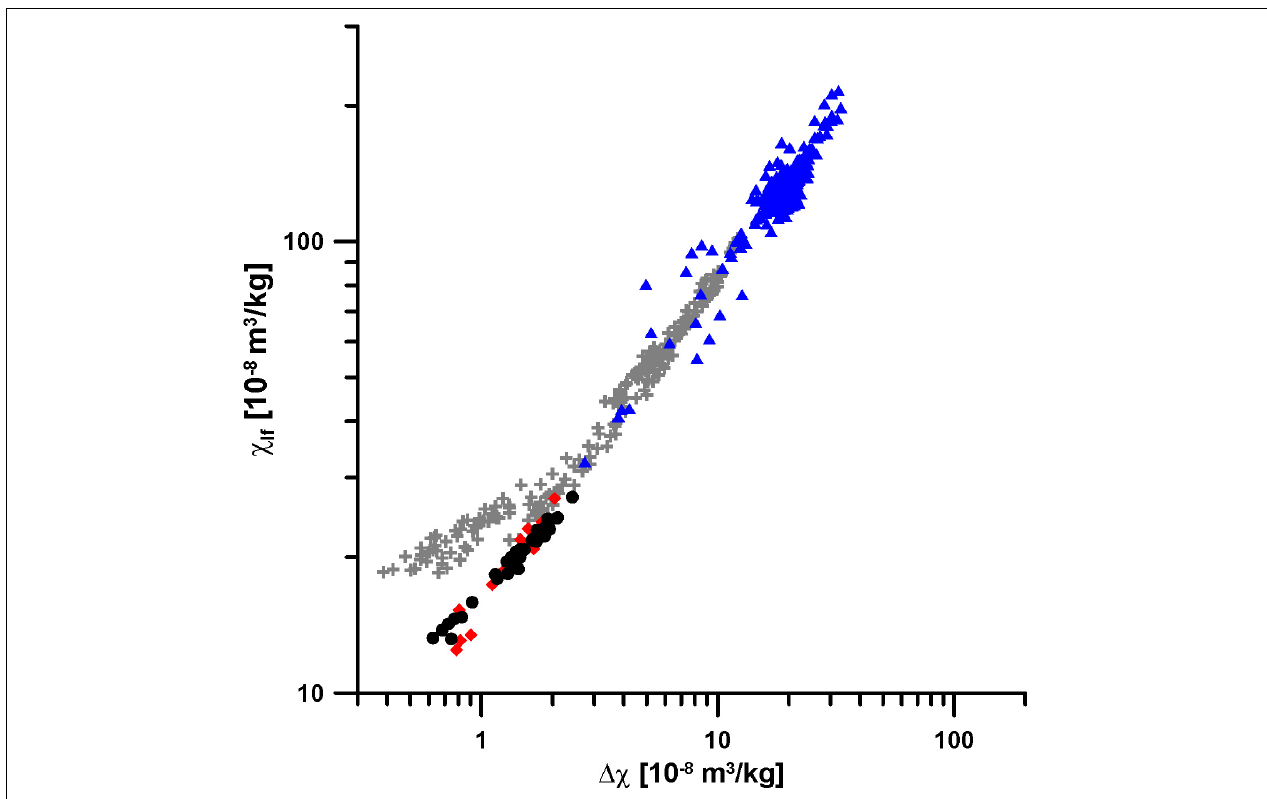
FIGURE 7 | Frequency-dependent susceptibility ( χ lf vs. (cid:49) χ ) of the Salagou Formation loess samples (red spades from Figure 3B ; black circles from Figure 3C ) compared to data from the Quaternary CLP red clay (blue triangles; Song et al., 2007) and a loess-paleosol section from Romania (gray crosses; Zeeden et al.,